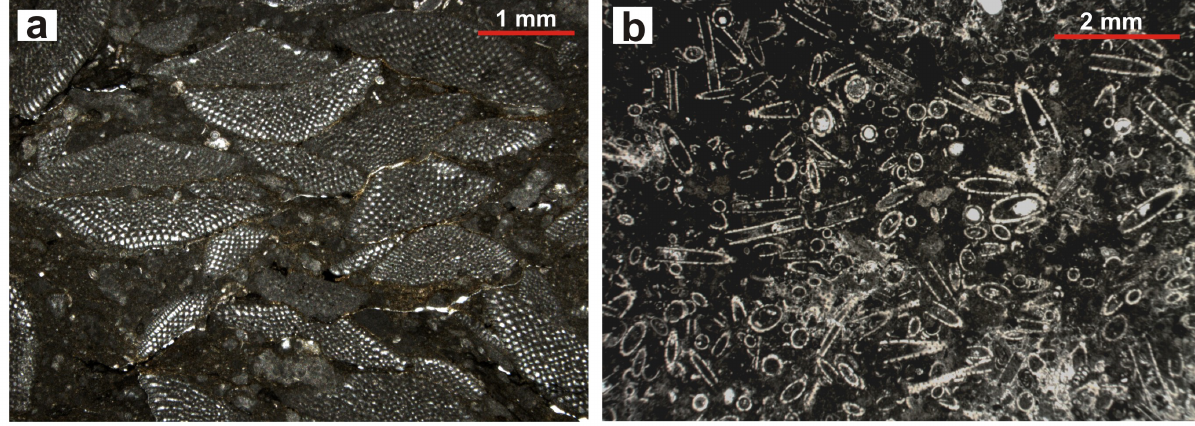
Fig. 7. (a) orbitolinid marly-packstone at Mt. Tobenna, microfacies (sample TB 8.3); (b) Salpingoporella dinarica acme at Mt. Motola, microfacies (sample MO